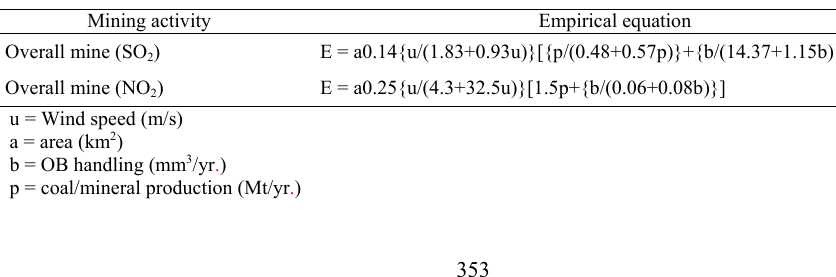
Table 2: Empirical formula for different mining activities